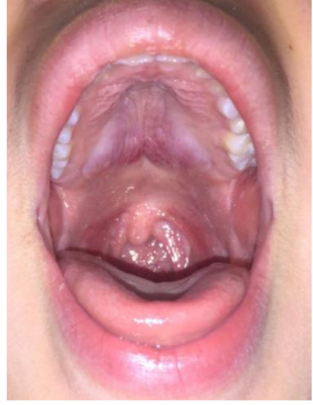
Figure 2. Patient 2: hard palatal